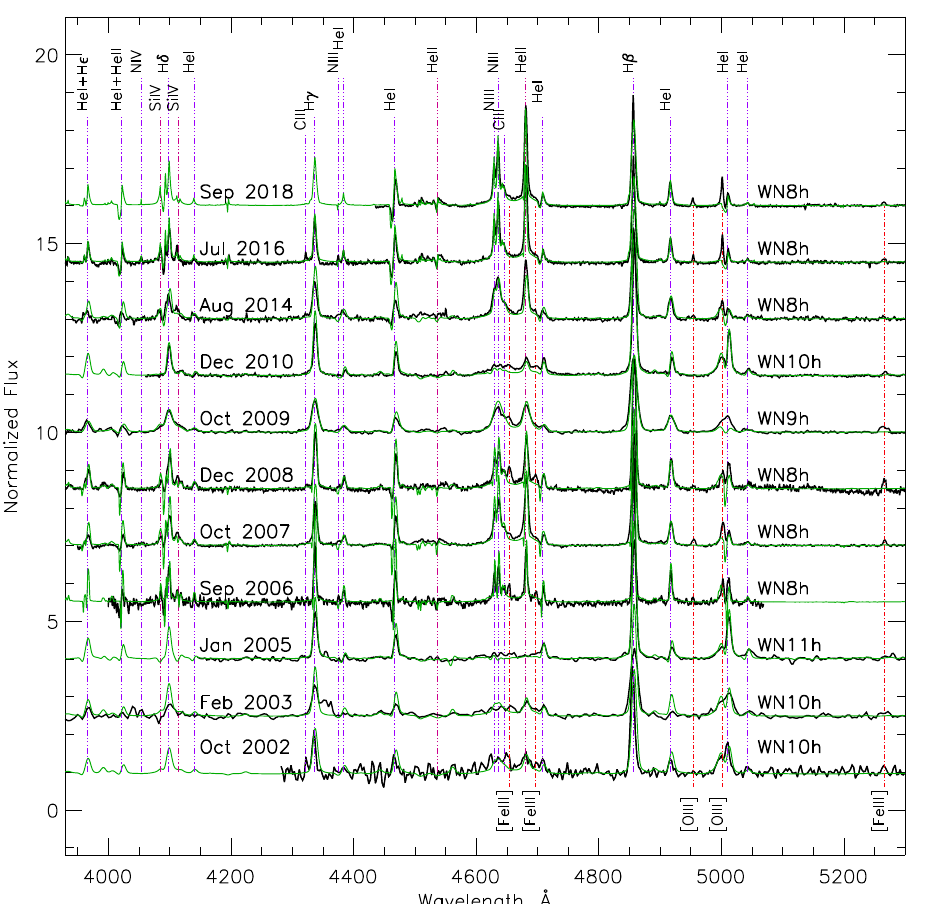
Figure 6. Normalised optical spectra of GR290 compared with the best-fit CMFGEN models (green line). The model spectra are convolved with a Gaussian instrumental profile. Description of observational data may be found in [10,22,23]. Notice that “September 2006” spectrum was obtained by P. Massey with WIYN 3.5m telescope [18]. Spectral types are estimated based primarily on relative strengths of NV, NIV, NIII, NII and HeII λ 4686 emission lines [48]. Spectra are displaced vertically